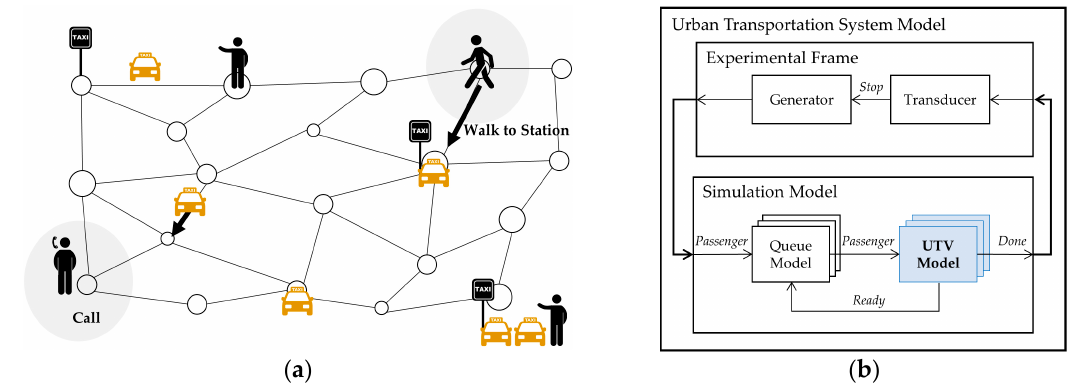
Figure 16. Case study for the discrete event system model: ( a ) UTV simulation scenario; ( b ) model structure of a UTV simulation.